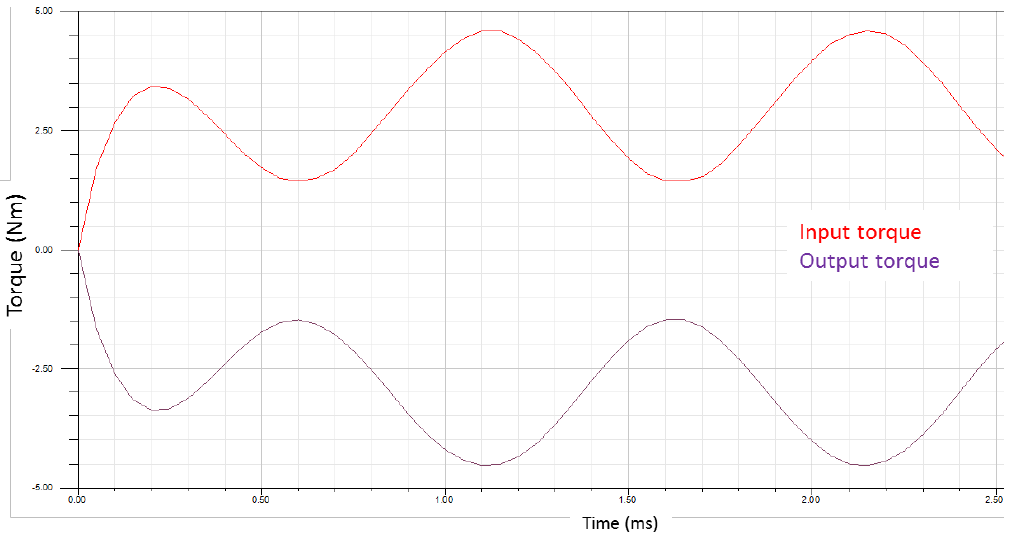
Figure 4. Drag torque in torque limiter mode.